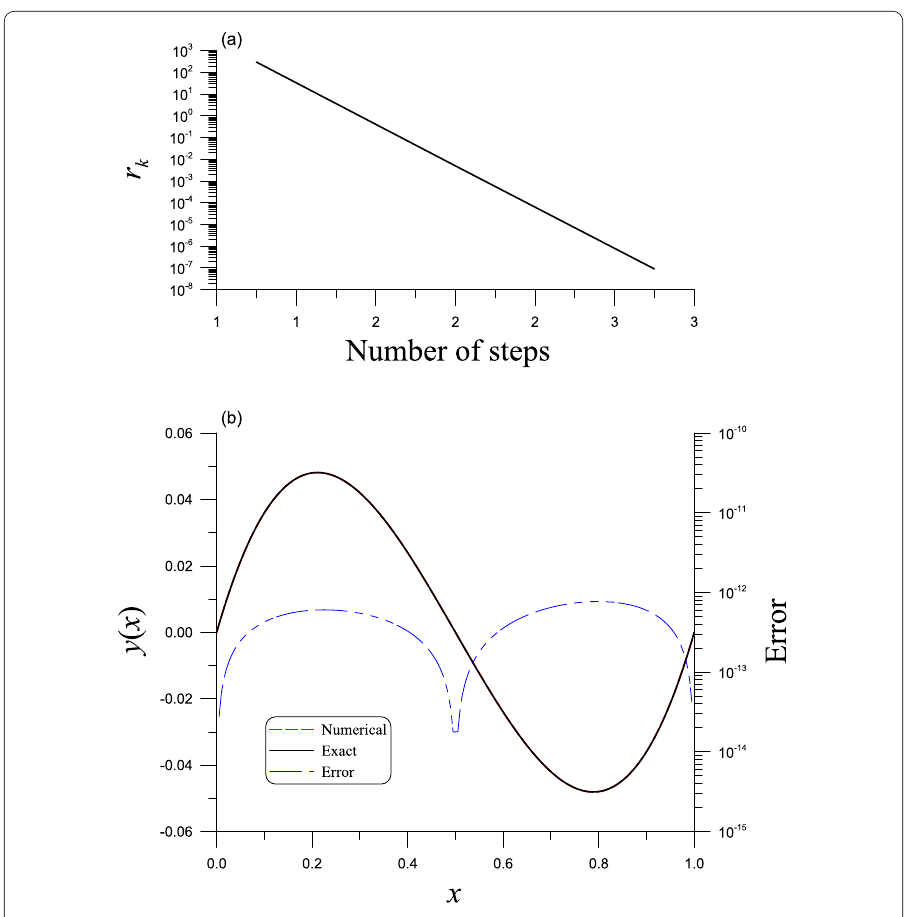
Figure 3 For Example 2 of a three-point BVP solved by the BSFM, ( a ) showing convergence behavior and ( b ) comparing numerical and exact solutions and showing numerical